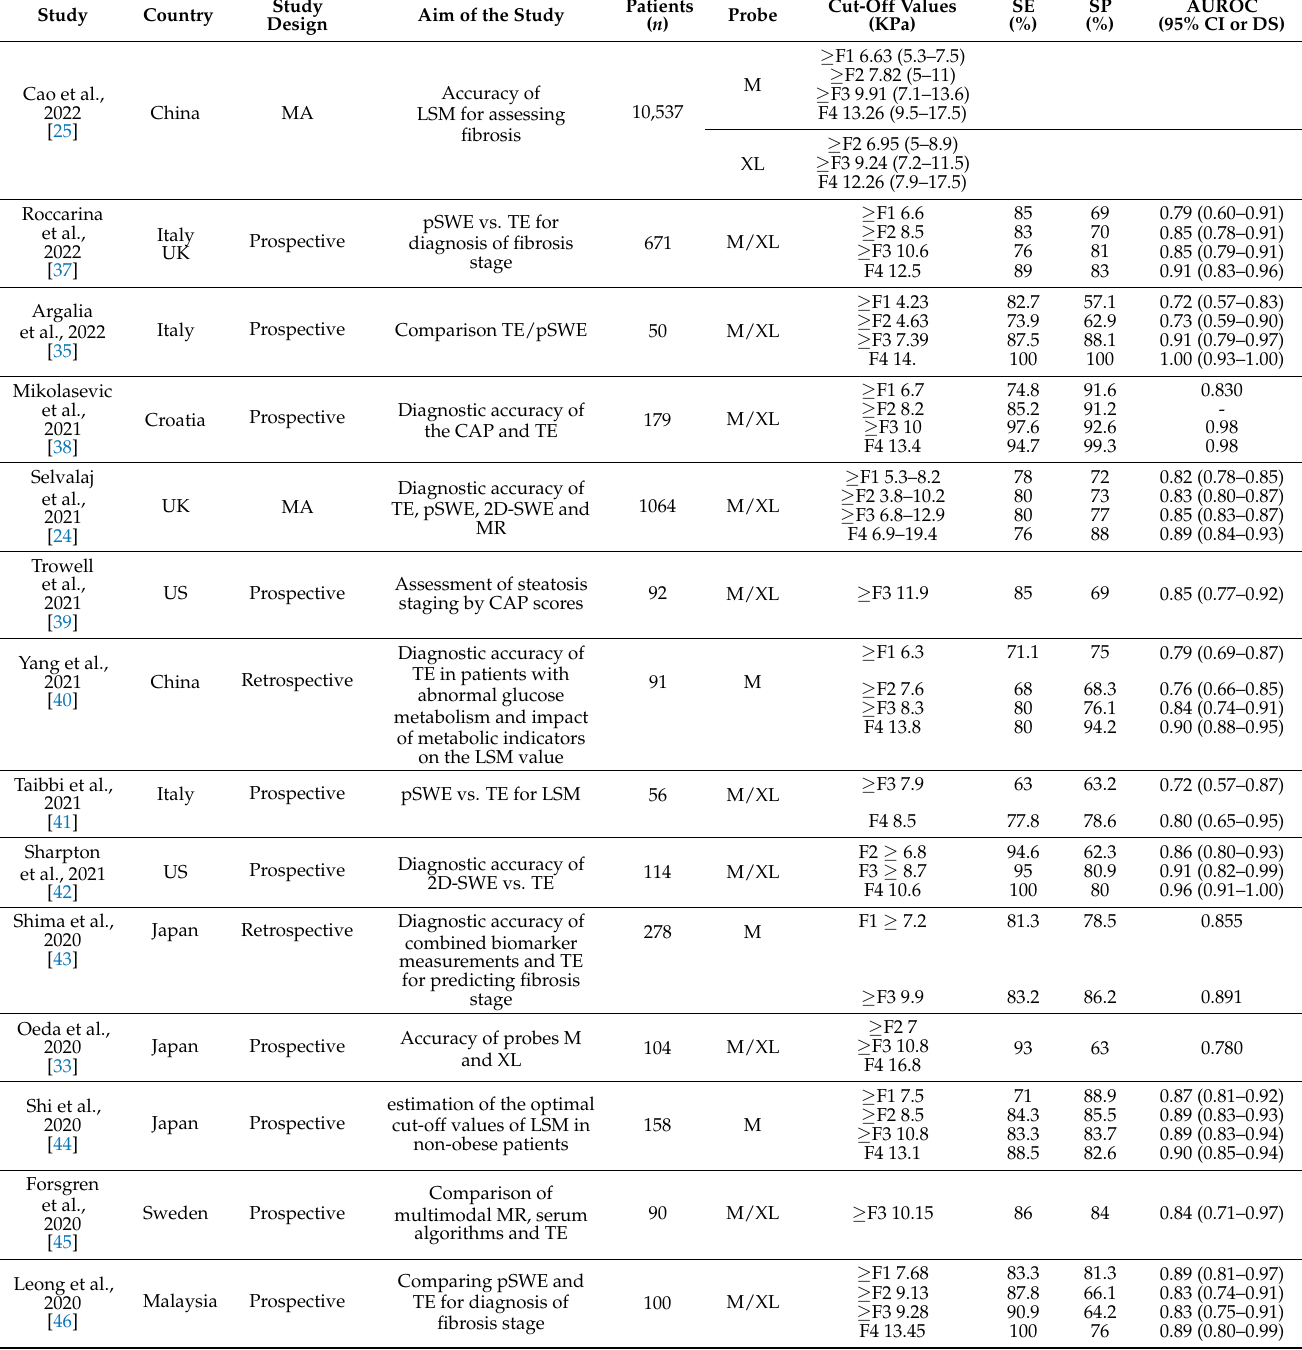
Table 1. Studies addressing the use of TE and cut-off values for staging liver fibrosis in NAFLD patients published in the last 10